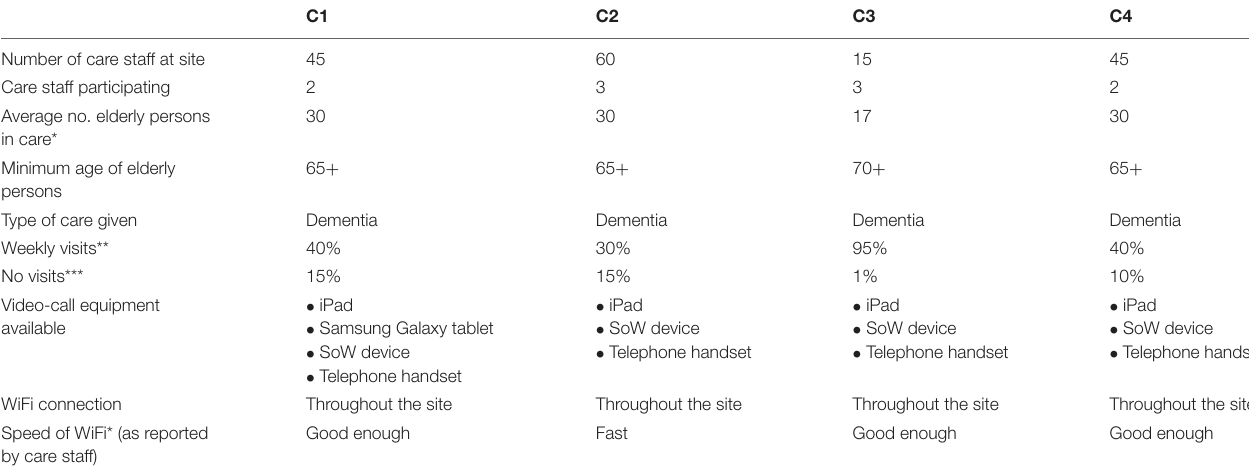
TABLE 1 | Characteristics of care homes